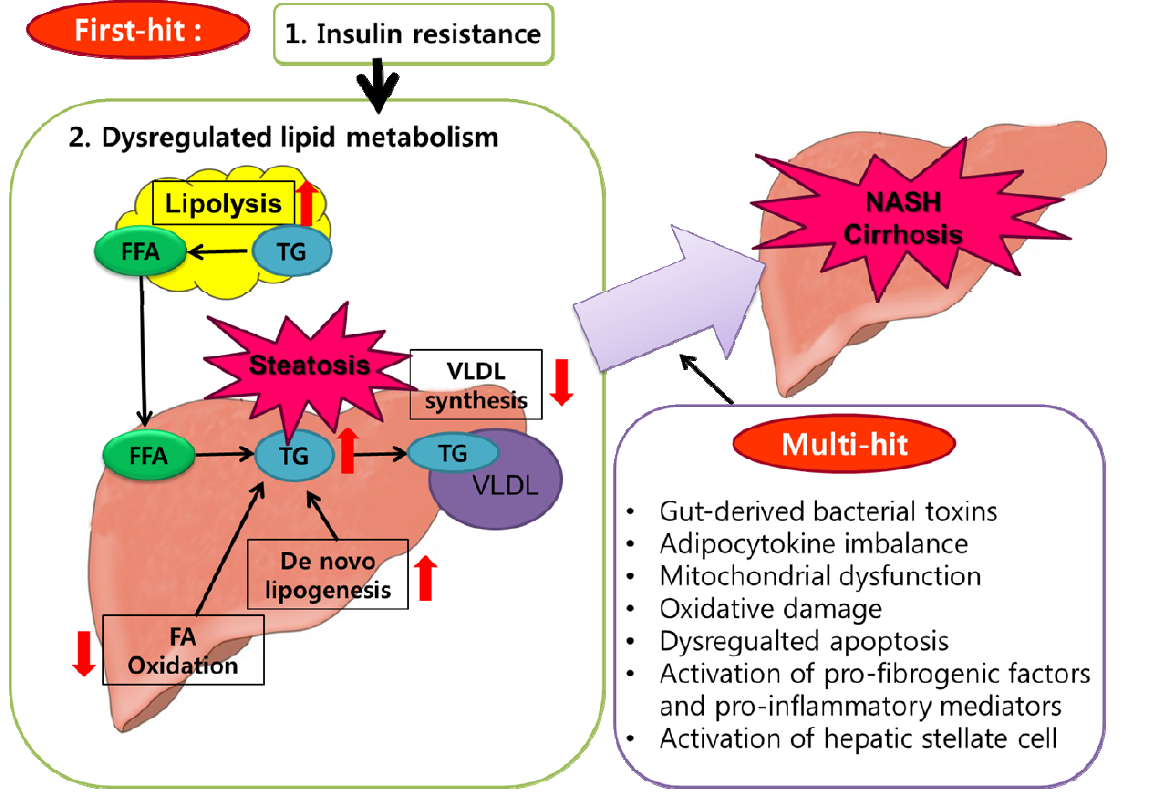
Figure 5. The Multi-hit hypothesis of NAFLD pathogenesis. The “first hit”, such as insulin resistance and lipid metabolism dysregulation, leads to the development of simple steatosis and renders hepatocytes susceptible to “multi-hit”, which include gut-derived bacterial toxins, adipocytokine imbalance, mitochondrial dysfunction, oxidative damage, dysregulated hepatocyte apoptosis, activation of pro-fibrogenic factors and pro-inflammatory mediators and hepatic stellate cell activation, ultimately leading to NASH and cirrhosis. The red arrows indicate up-regulation (when pointing upward) or down-regulation (when pointing downward) in response to insulin